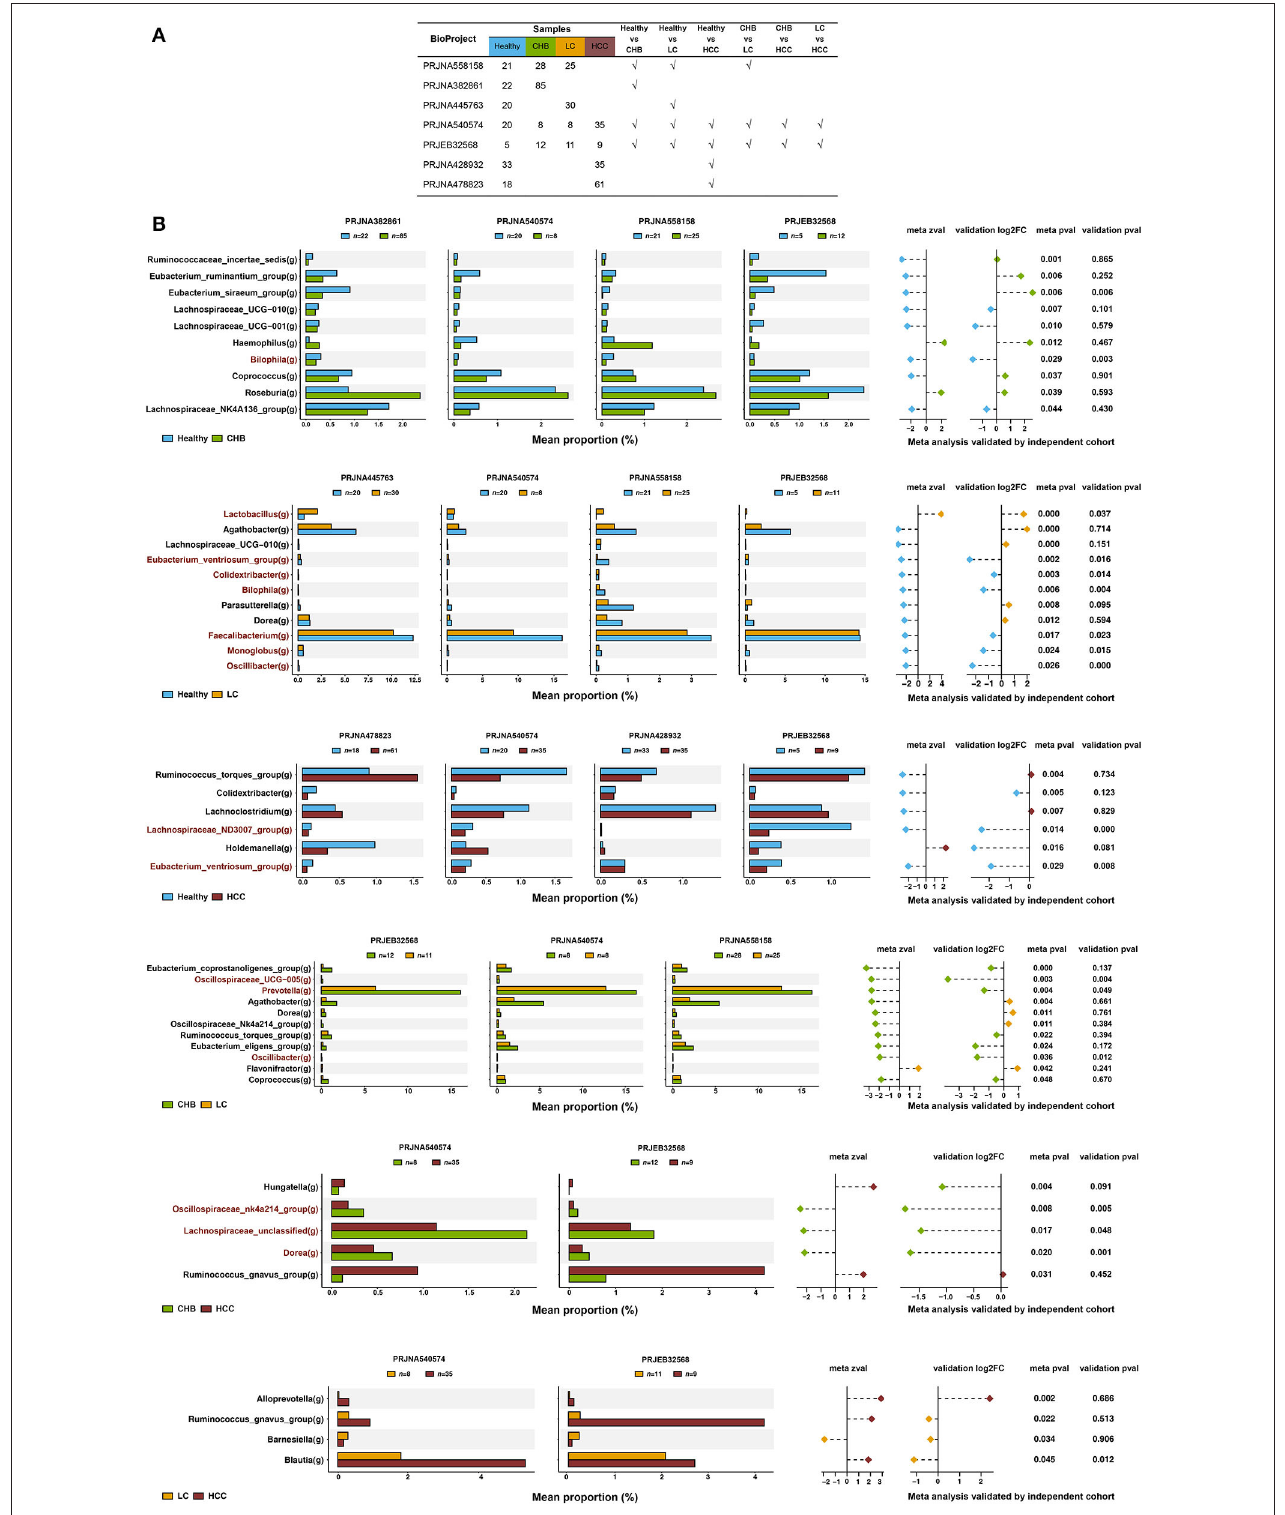
FIGURE 2 | Signature microbiome taxa identified in the meta-analysis. (A) The public datasets included for each pair wise comparison. (B) Mean proportion of each genus between groups of interest in each individual dataset, and the summary statistics for the random effect meta-analysis for each pair wise comparison. The genus was highlighted by red if it was consistently and significantly altered in both public and validation datasets. Shown are the genera at the p -value threshold of 0.05.